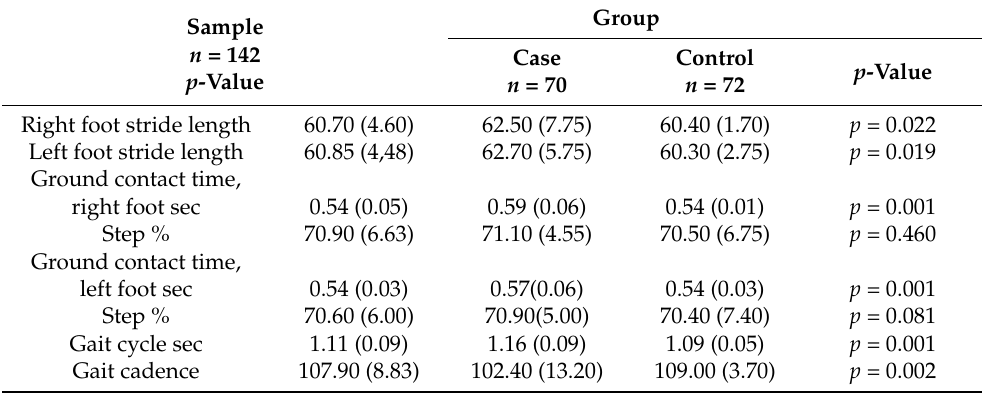
Table 2. Descriptive statistical analysis after the OptoGait sensor gait analysis between the control and case